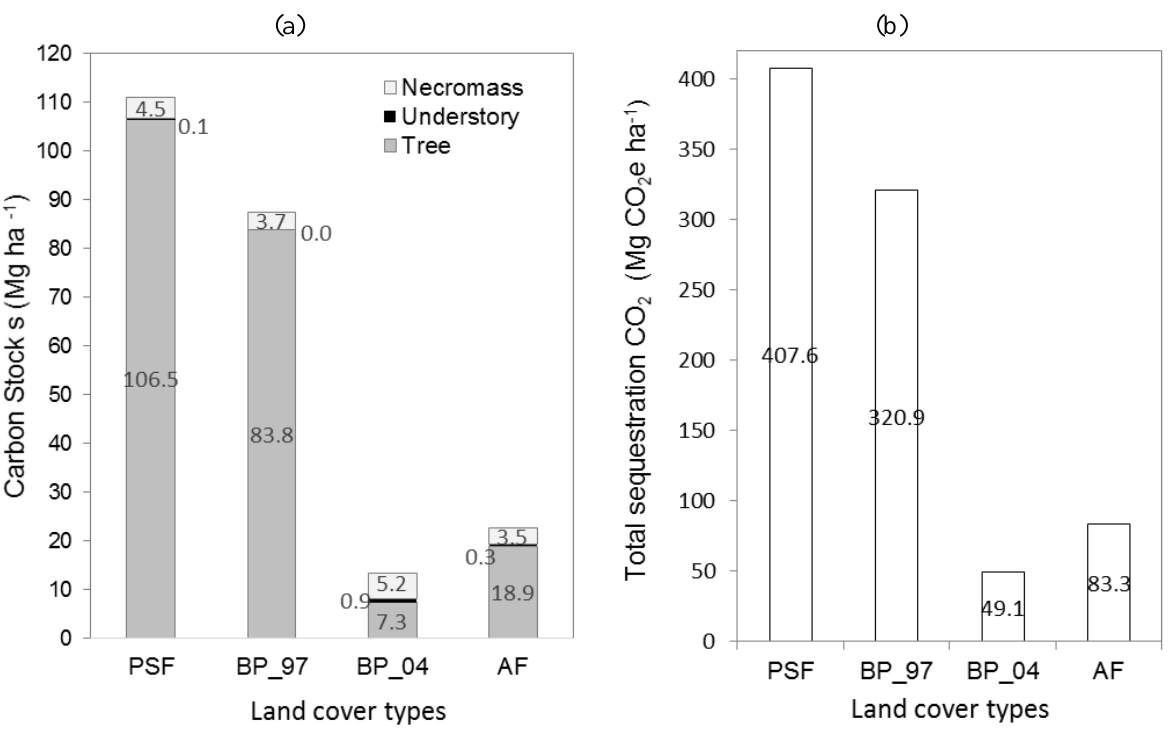
Figure 5. Above-ground carbon stocks (a) and total sequestered CO types at Tumbang Nusa. The land cover types are: peat swamp forest (PSF; 2 plots), peatland burned in 1997 (BP_97; 1 plot), peatland burned in 2004 (1 plot), and agroforestry (AF; 3 plots with jelutung+rubber, jelutung+ N. lappaceum and jelutung+ Acacia , respectively).